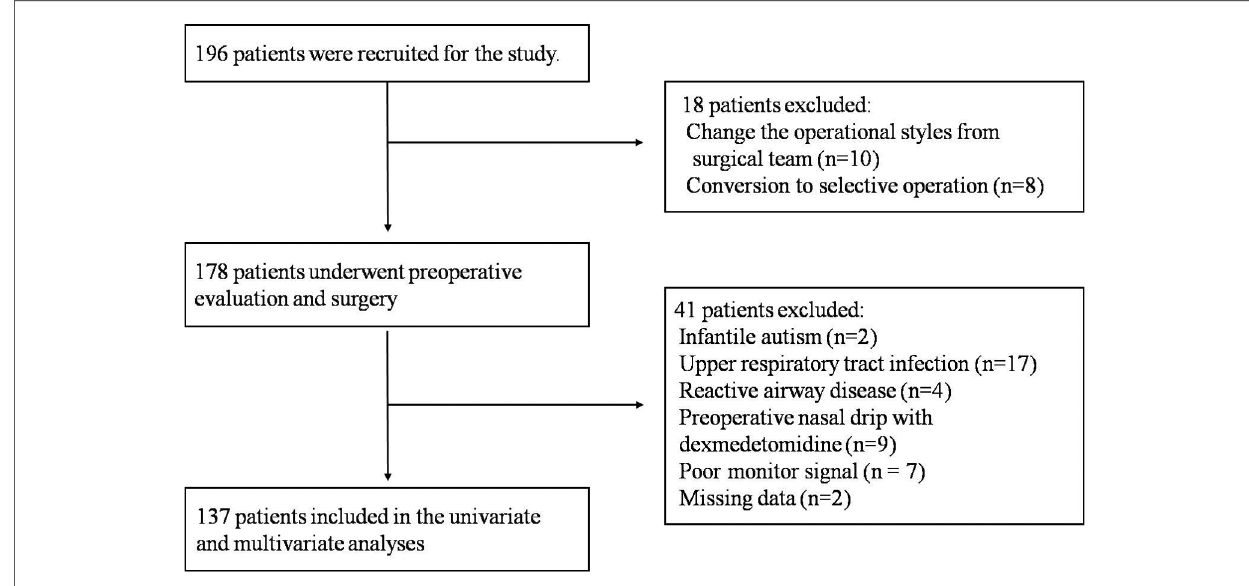
FIGURE 1 Patient fl ow diagram showing the number of patients included and